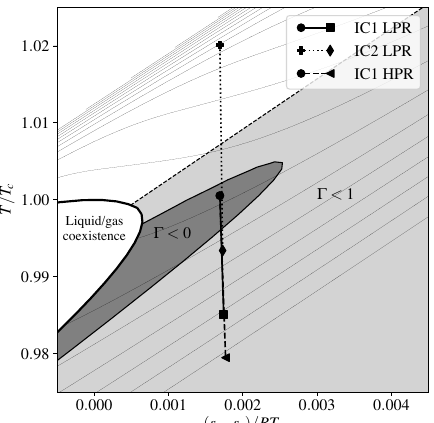
Figure 1. Temperature–entropy chart for PP11 (Martin–Hou equation of state). Expansion lines for the three cascades considered in the study. The bold solid line corresponds to the liquid/vapor coexistence curve; the dashed line represents the Γ = 1 contour; the dark gray region corresponds to the inversion zone; the light gray region corresponds to Γ < 1. Conditions at the turbine inlet and outlet are computed as average values on the inlet and outlet boundaries of the computational